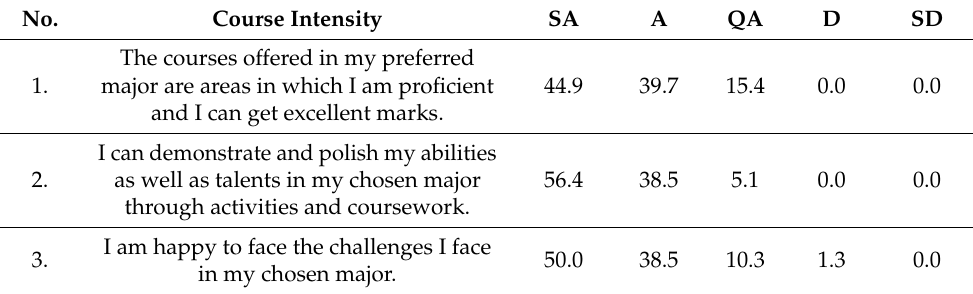
Table 6. Creative Arts Program Course